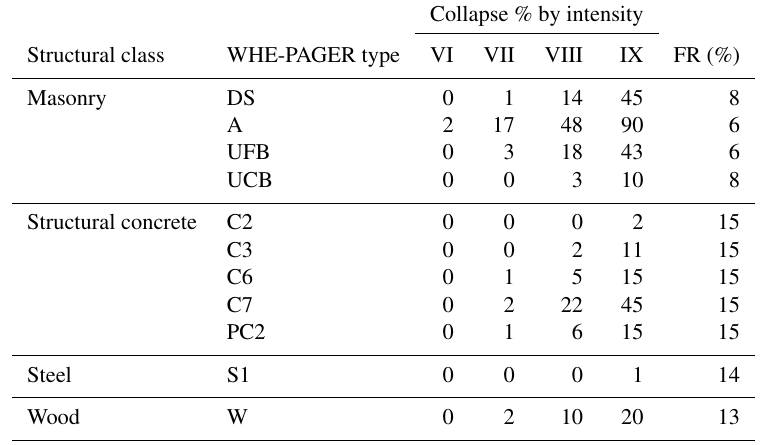
Collapse % by intensity